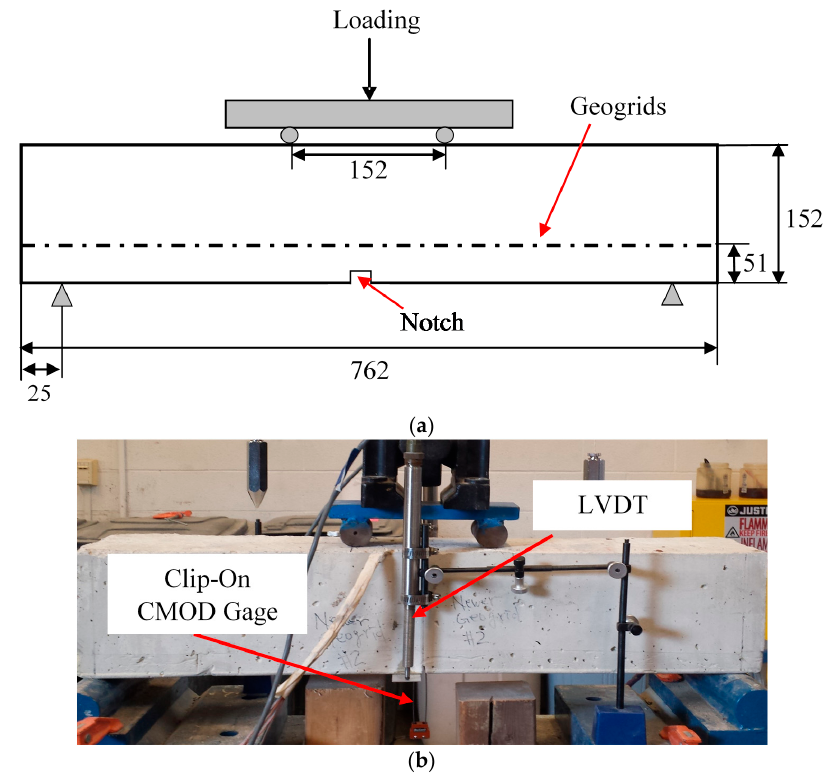
Figure 3. Test setup and instrumentation: ( a ) schematic and dimensions of test setup, units in mm; ( b ) instrumentation of tests.